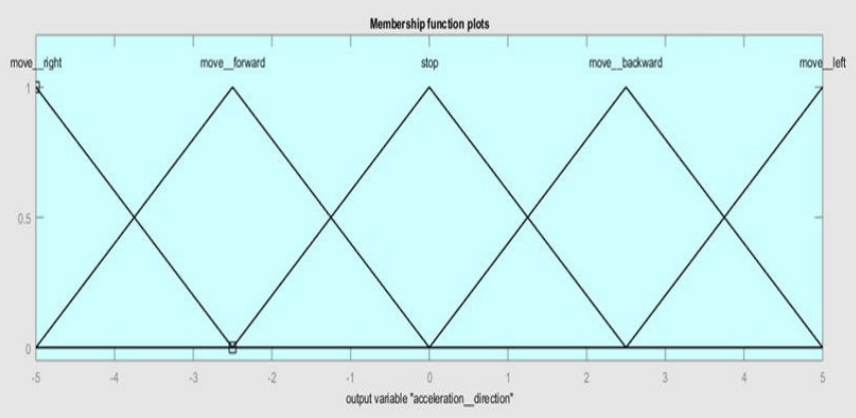
Figure 9. Membership functions of output 2 (acceleration direction).